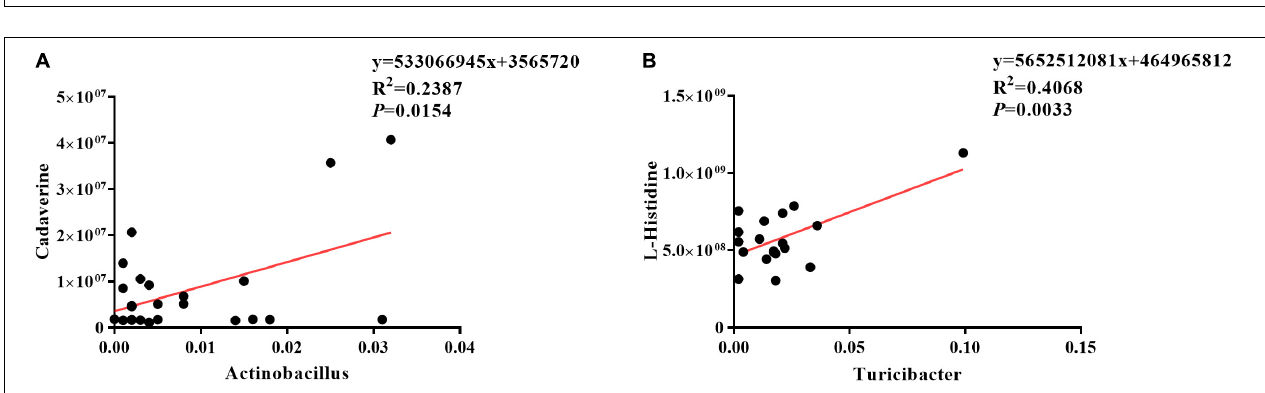
FIGURE 7 | Effects of OKG supplementation on KEGG pathway enrichment in ETEC- infected pigs. (A) ETEC vs. CON on positive mode. (B–C) CON vs. OKG on positive and negative mode. (D–E) OKG vs. OKG ETEC on positive and negative mode. (F) ETEC vs. OKG ETEC on positive mode.